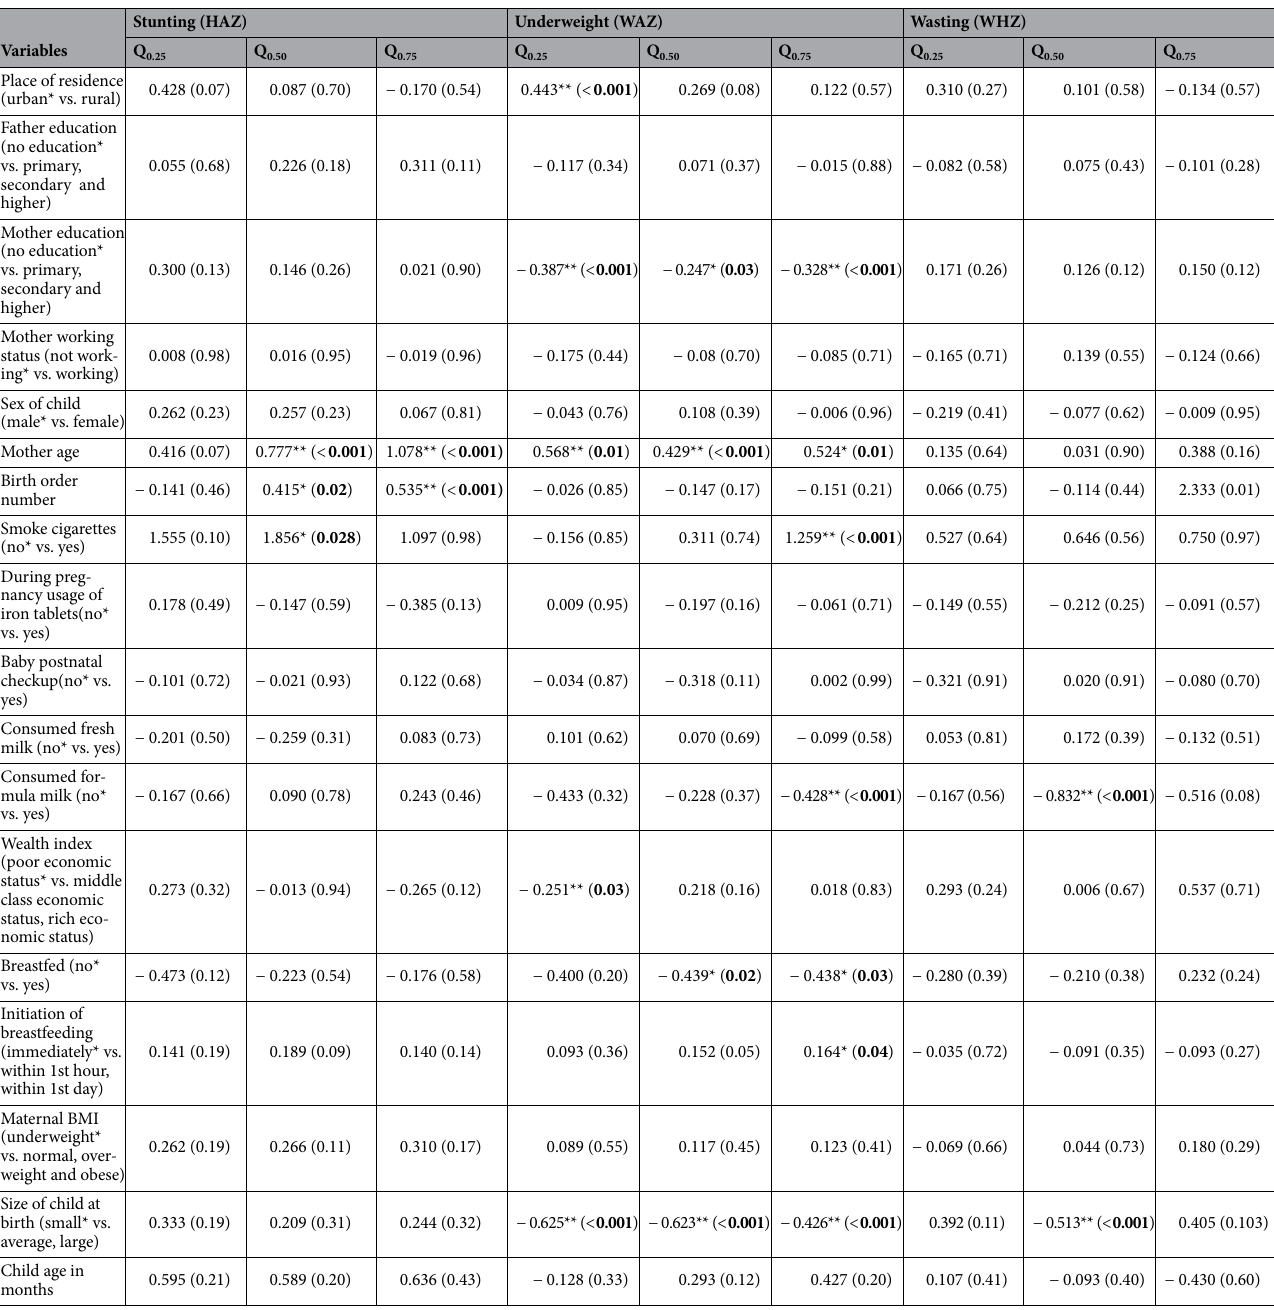
Table 3. Quantile regression estimates for factors associated with stunting (HAZ), underweight (WAZ), and wasting (WHZ) below five years of age—PDHS (2017–2018). **Indicate at 0.01, *indicate at 0.05, significant p values shown in bold. * indicating reference